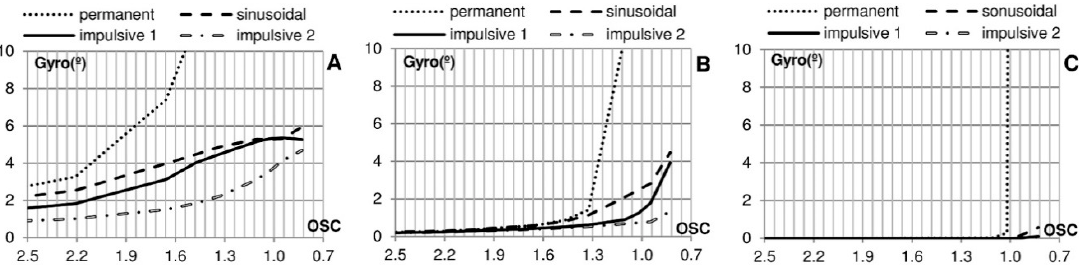
Figure 22. Crown wall rotation as a function of OSC and the shape of the signal, assuming elastic soil ( A ) E (MPa) = 10; ( B ) E (MPa) = 100; ( C ); E (MPa) = 27,000.